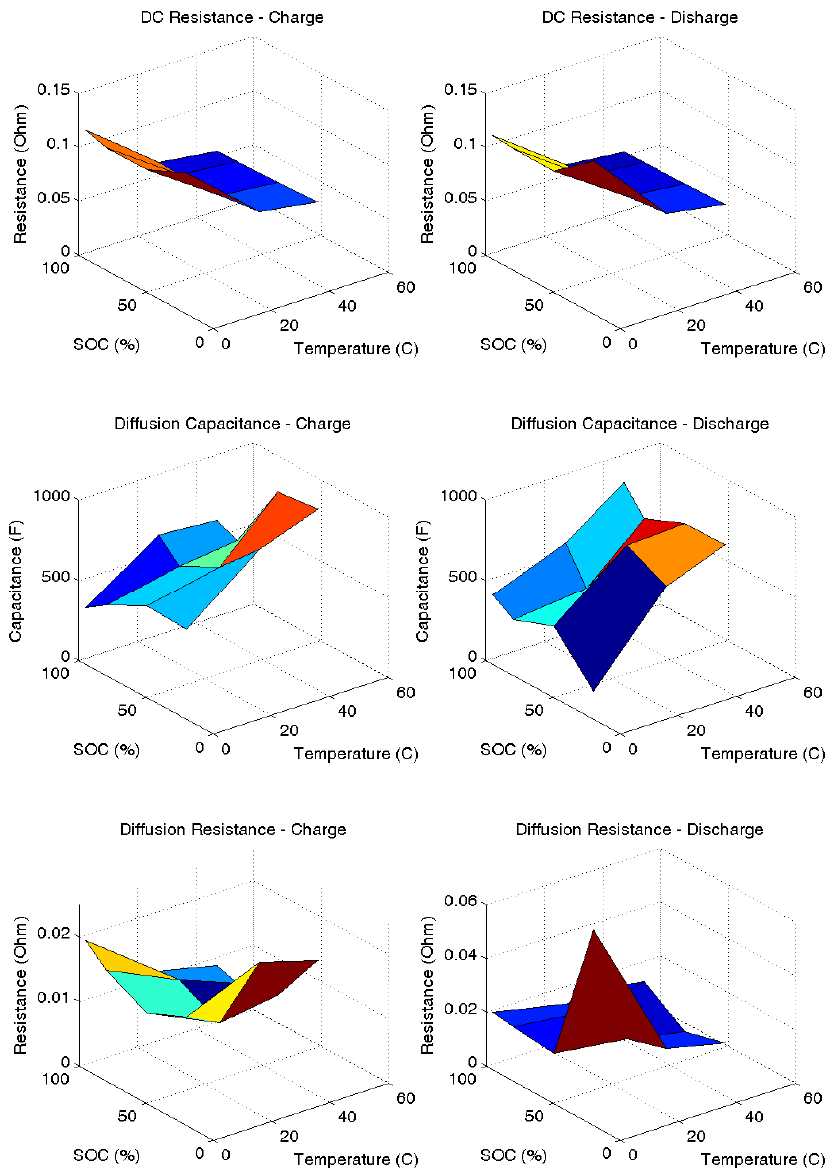
Figure 2. ECM parameter